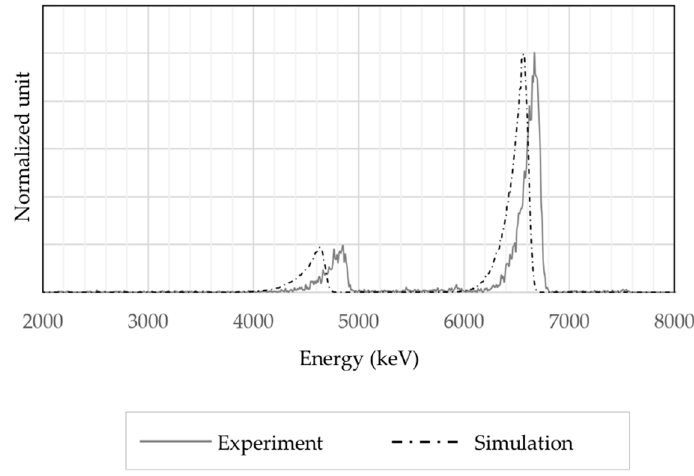
Figure 8. Comparison between an experimental spectrum and a simulated one for the two alpha emissions of 218 Po and 214 Po in the equivalent layer approach.